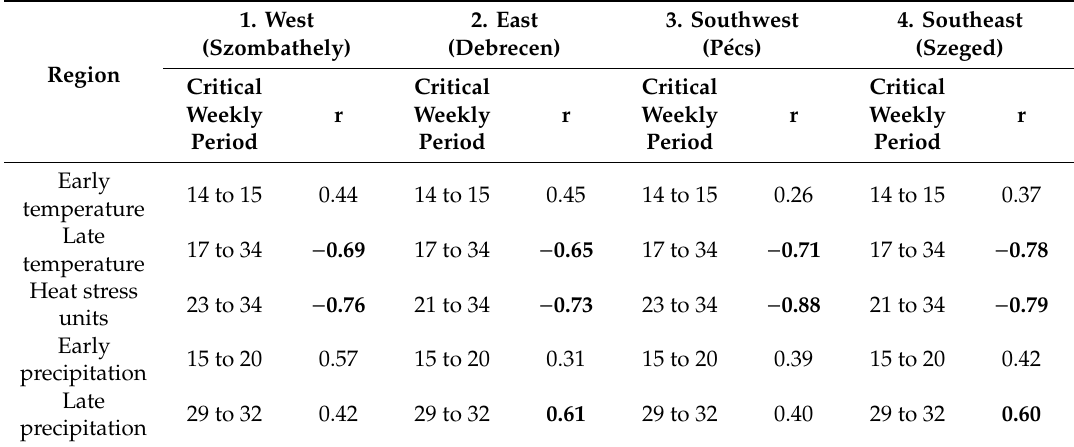
Table 3. The critical weekly periods and the linear correlation coe ffi cients for the period 1990–2019. 1. Region